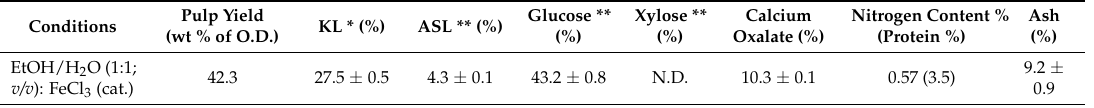
Table 4. Constituents of cellulosic pulp obtained from bark of sugar